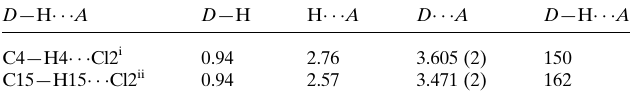
Table 1 Hydrogen-bond geometry (A˚ , (cid:4) ).